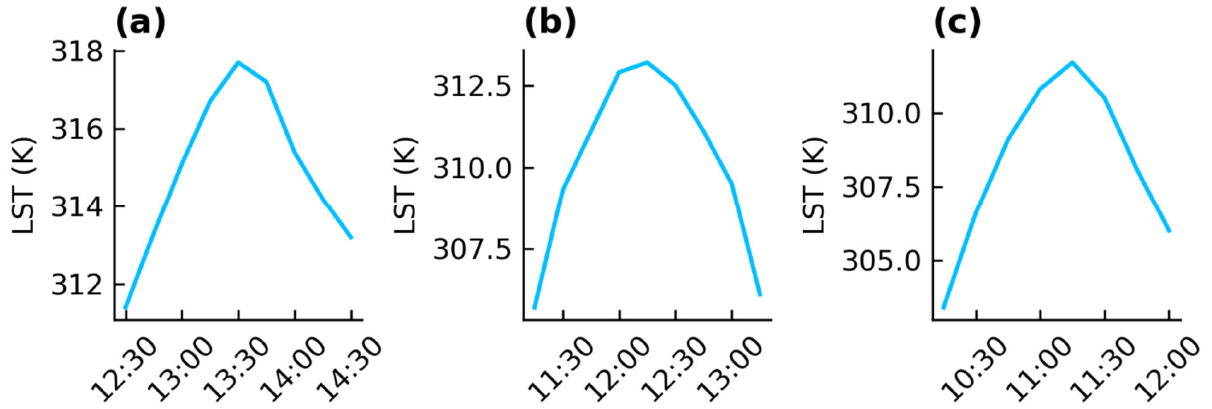
Figure 2. Mean daytime MODIS LST (Aqua, MYD11A1) (June–August 2002–2020) as a function of the local overpass time (in UTC) for the locations of GHCNd stations ( a ) SP000008410 (Cordoba, Spain), ( b ) IT000016239 (Rome, Italy), and ( c ) TU000017375 (Finike, Turkey).